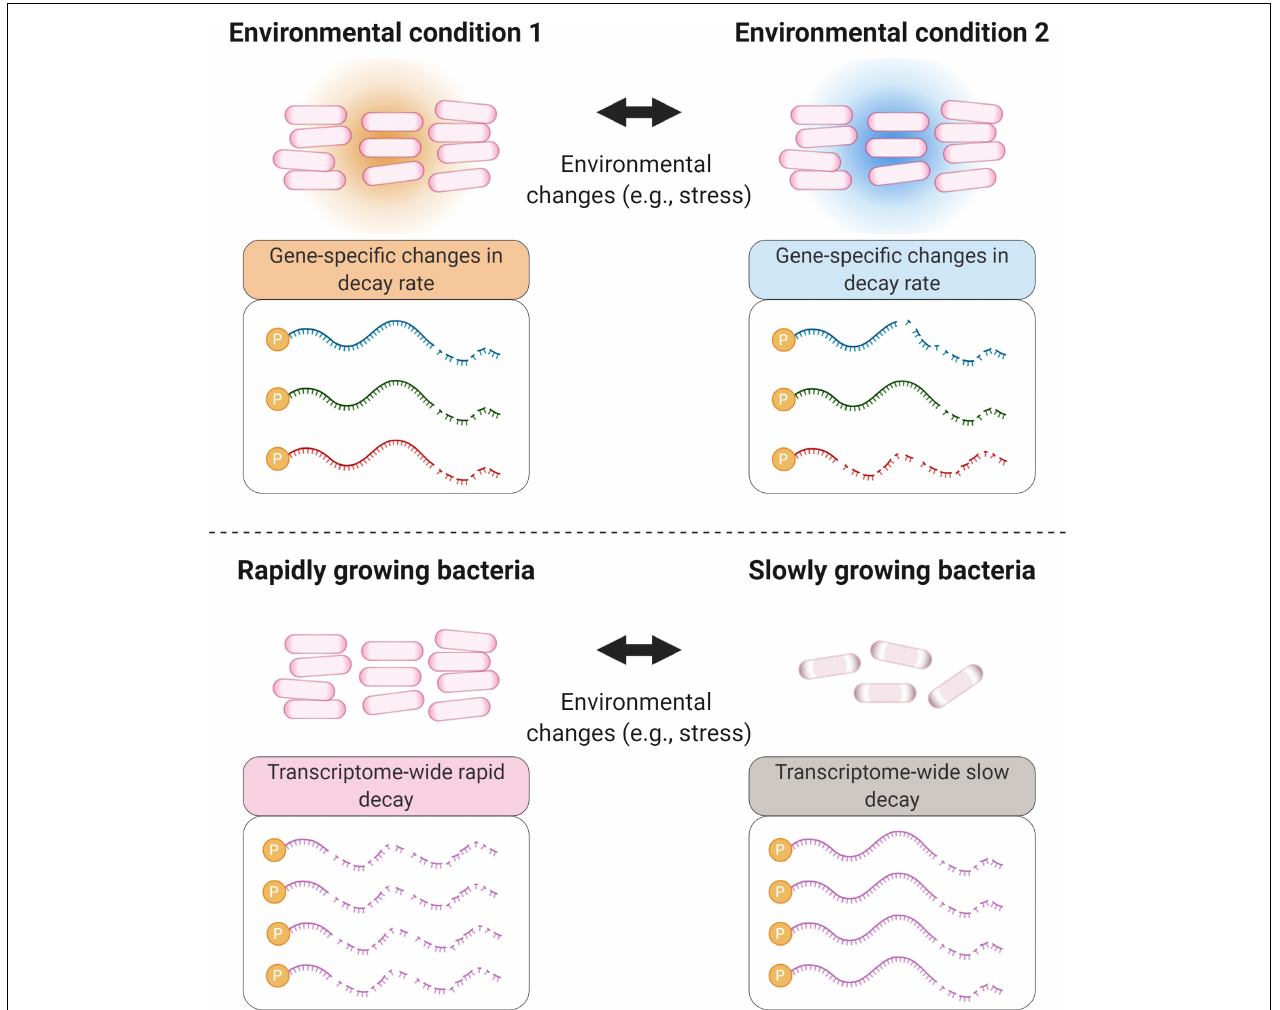
FIGURE 1 | Environmental changes cause mRNA degradation rates to change in both global and gene-specific ways. Bacterial adaptation to many stressors, and other changes in environment, involve modulation of degradation rates of specific transcripts encoding proteins relevant to the changing conditions (top panel). Some stressors, particularly those causing severe energy stress, trigger global stabilization of the mRNA pool (bottom panel). These scenarios are not mutually exclusive; stressors that cause global transcriptome stabilization typically also cause gene-specific changes in relative degradation